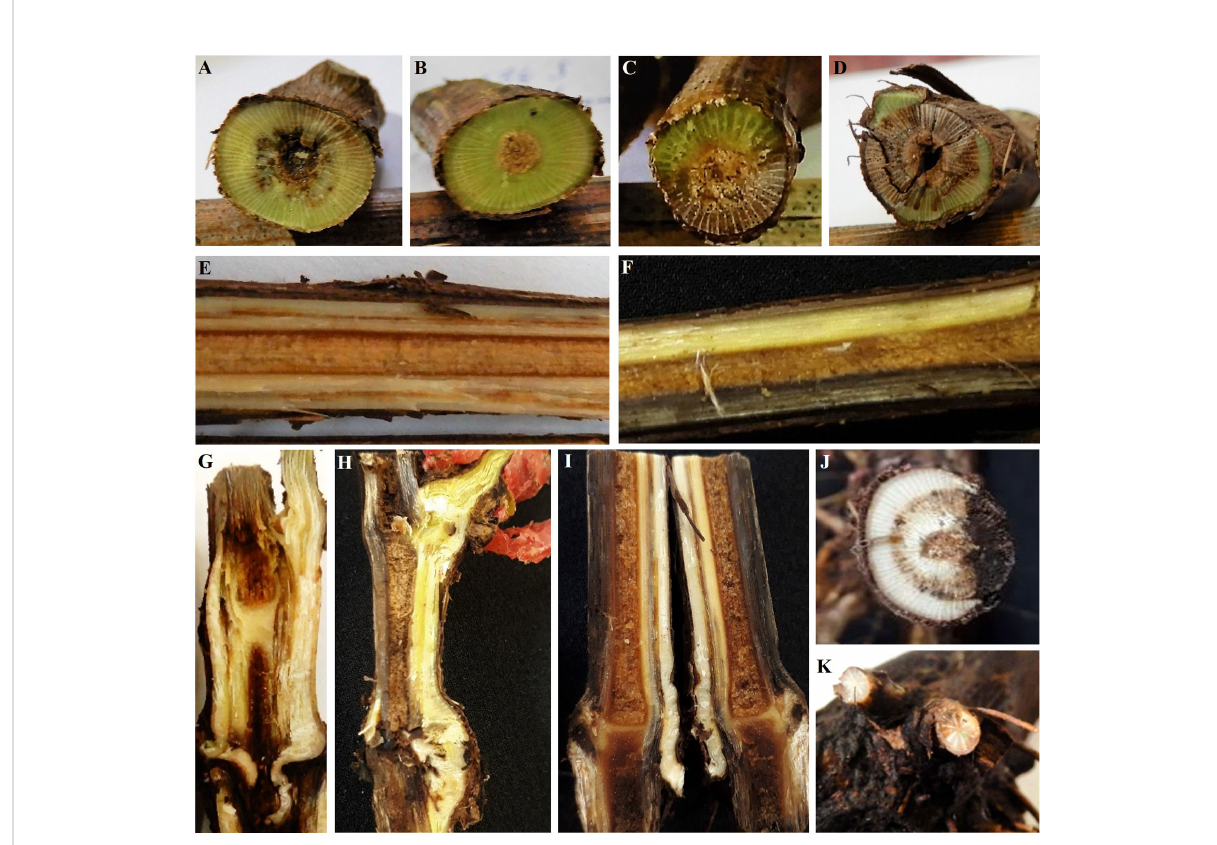
FIGURE 1 Internal symptoms caused by fungal pathogens associated with grapevine trunk diseases. Cross section of cuttings showing (A, B) black discoloration of the xylem vessels seen as black spots and (C, D) sectorial wood necrosis. Longitudinal section of cuttings showing (E) black discoloration of the xylem vessels seen as dark streaks and (F) sectorial wood necrosis. Longitudinal section of the graft union area showing (G) dark streaks and (H) sectorial wood necrosis. Longitudinal section of the base of the rootstock showing (I) dark streaks that develops from the base and sectorial wood necrosis. Cross section of the base of the rootstocks showing (J) a half-ring of black spots and sectorial wood necrosis. Cross section of roots showing (K) sectorial wood